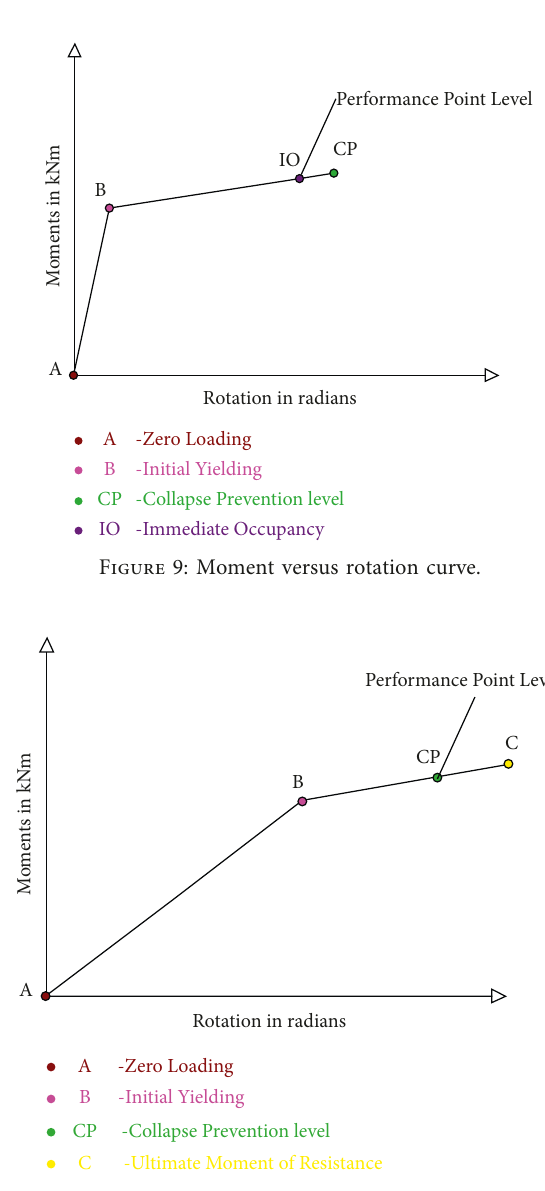
Figure 10: Moment versus rotation